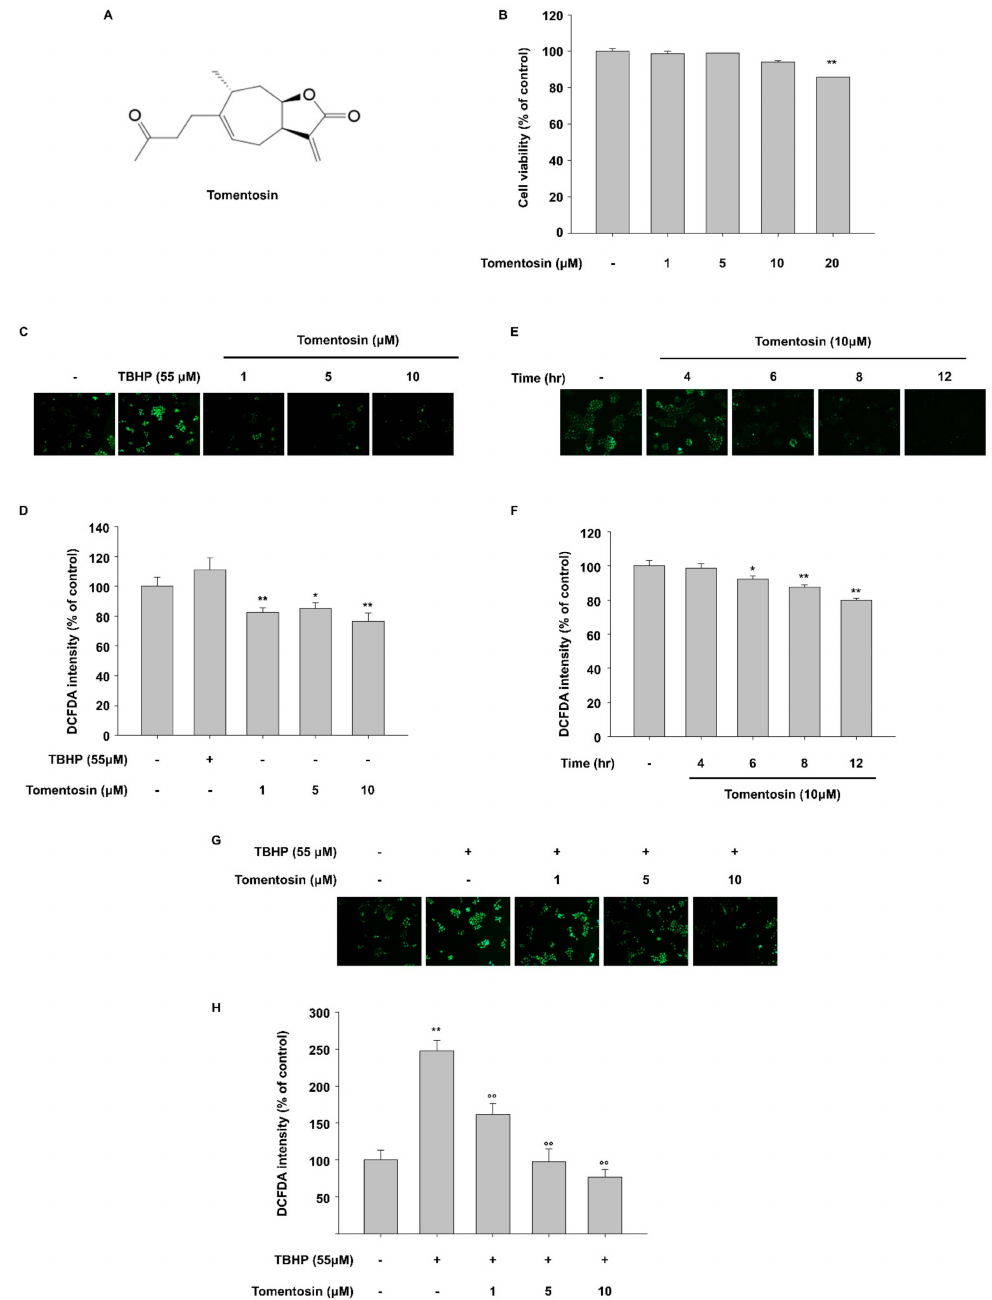
Figure 1. Tomentosin decreases reactive oxygen species (ROS) in a time- and dose-dependent manner in HaCaT cells. ( A ) Chemical structure of tomentosin. ( B ) Cell Counting Kit-8 (CCK-8) was intro- duced for determining cell viability. HaCaT cells were cultured with the indicated concentrations of tomentosin for 24 h and subjected to CCK-8 analysis. The data are presented as the mean ± SD of trip- licates. ( C , D ) HaCaT cells were pretreated with tomentosin for 24 h prior to treatment with 20 µ M 2 (cid:48) ,7 (cid:48) dichlorofluorescin diacetate (DCFDA) for 20 min, and then subjected to fluorescence microscopy (Orig- inal magnification = 10 × ) ( C ) or microplate-based fluorescence intensity analysis ( D ). The data are presented as the mean ± SD of triplicates. ( E , F ) HaCaT cells were pretreated with 10 µ M